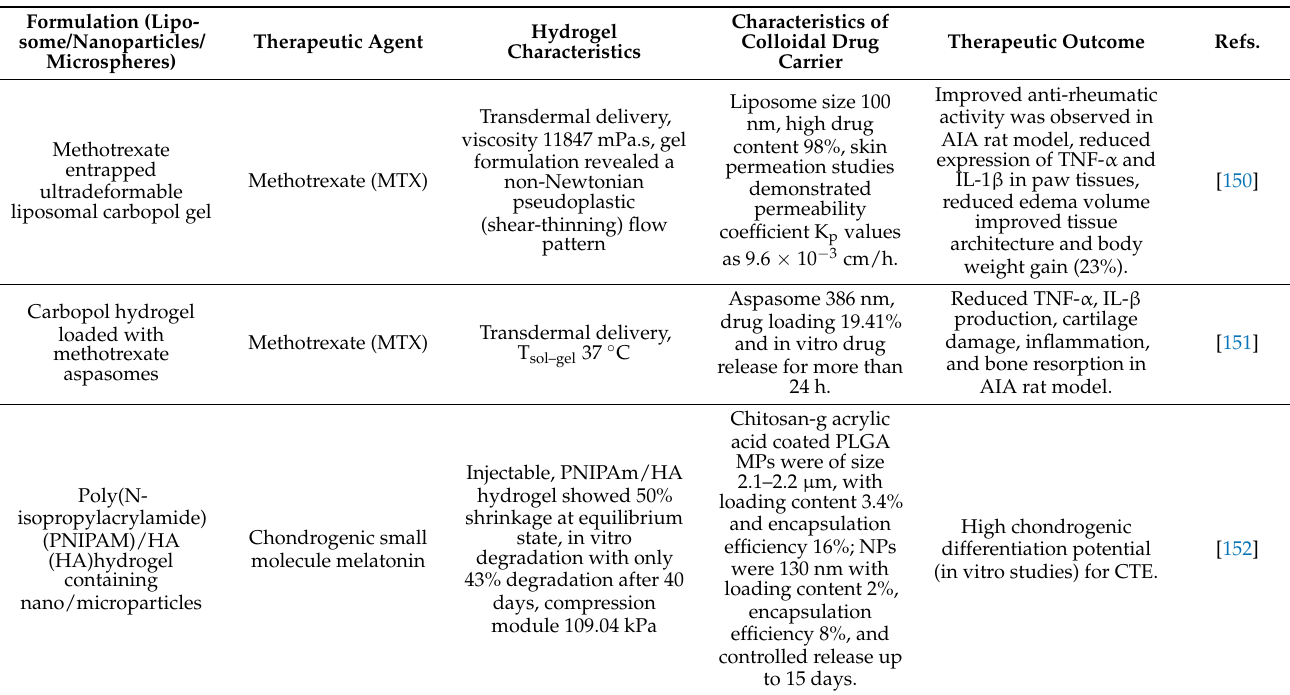
Table 2. Nano/microcomposite integrated hydrogel composite for arthritis